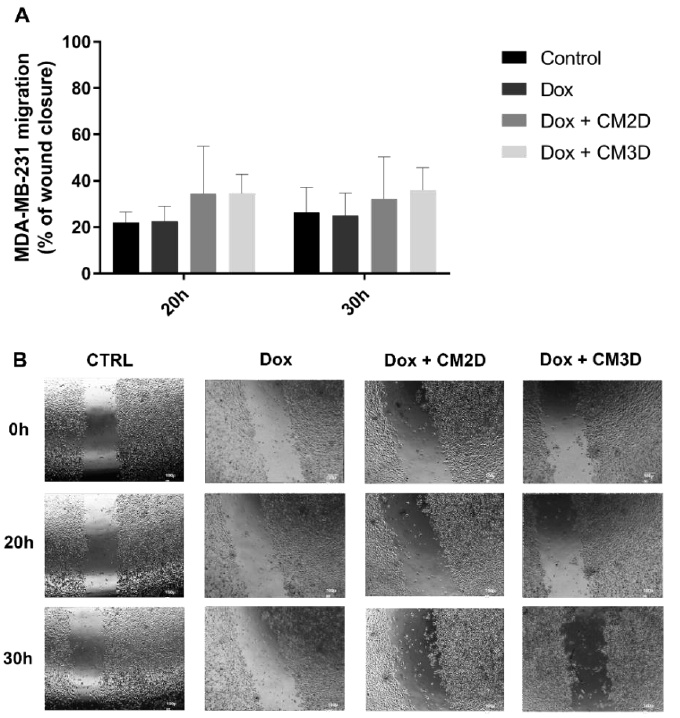
Figure 3. Co-exposure of MDA-MB-231 cells to Dox and MSC CM did not affect cell migration. ( A ) The effect of CM2D or CM3D in combination with Dox (100 nM) on the migration of MDA-MB-231 cells at the 20 and 30 h time points was evaluated by scratch assay. Cell migration is represented as percentage (mean ± SD, n = 3–6) of wound closure at the defined time points. ( B ) Representative images of scratch assays of MDA-MB-231 cells incubated with or without MSC CM (control) immediately after the scratches were made (0 h) and after 20 and 30 h. Magnification 4×, scale bar = 100 μm. CM2D, conditioned medium derived from 2D cultures; CM3D, conditioned medium derived from 3D cultures; Dox, doxorubicin.